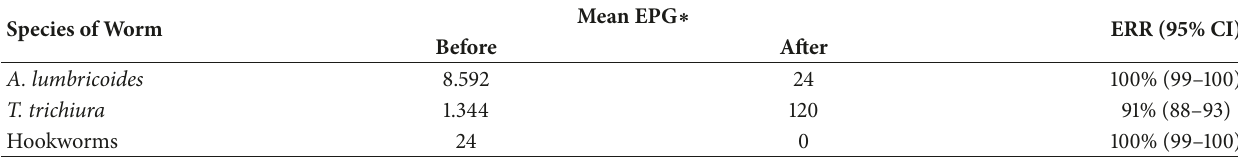
Table 3: The comparison of EPG before and after